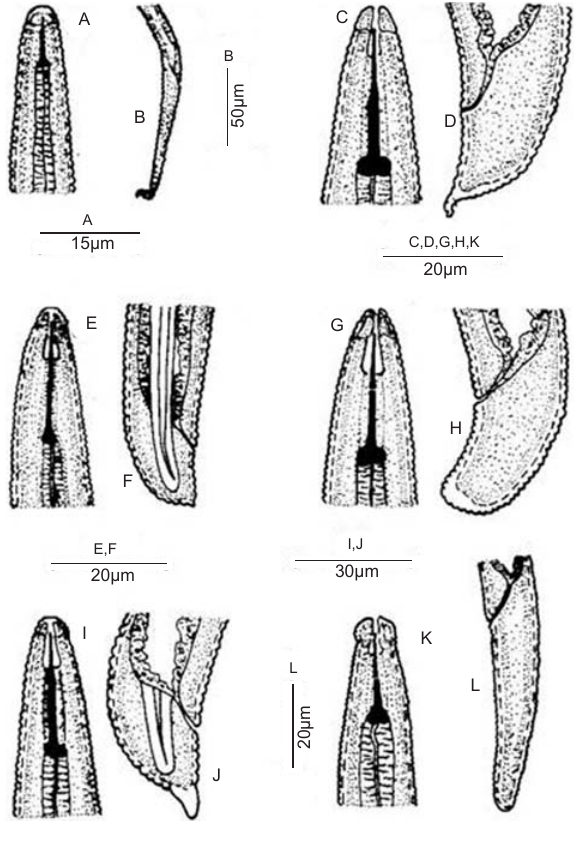
Figure 1. Zanenchus zanchus Siddiqi, 1979 A - Anterior end; B - Posterior